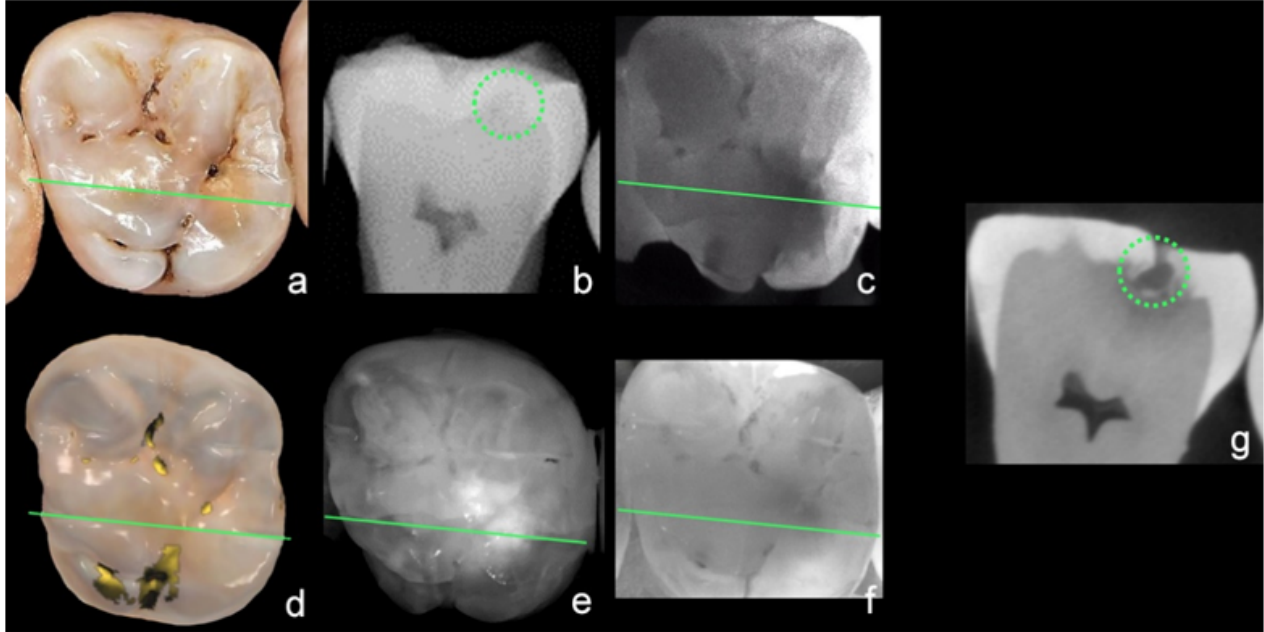
Figure 8. Example of all investigated caries diagnostic methods: visual examination ( a ), bitewing radiography ( b ), Diagnocam ( c ), Trios 4 ( d ), iTero Element 5D ( e ), Planmeca Emerald S ( f ), and µ-CT reference ( g ); green line shows plane of µ-CT, green circle marks caries lesion in sectional image.